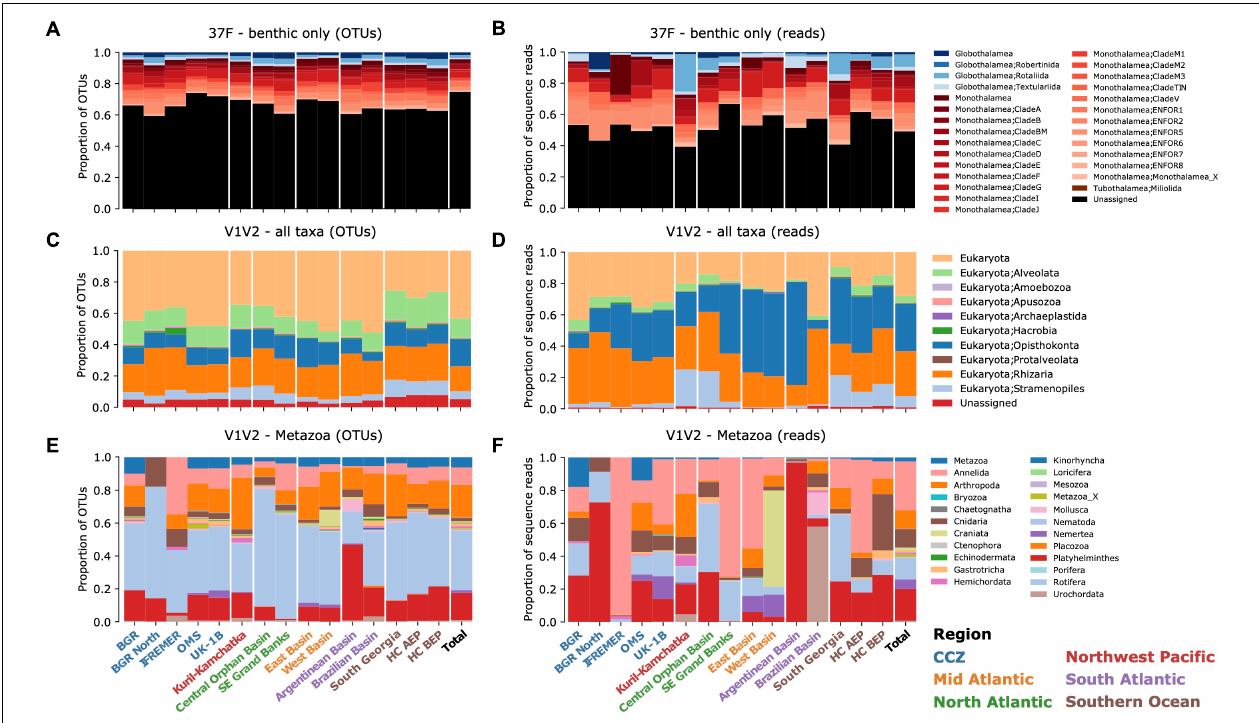
FIGURE 2 | Taxonomic composition and relative abundance. Proportions of OTUs found for each taxon across samples from each area (A,C,E) and relative abundances of reads per taxon (B,D,F) . (A,B) the 37F dataset (benthic Foraminifera only), (C,D) the full V1V2 dataset, and (E,F) the V1V2 dataset reduced to Metazoa. Bars are grouped per region and the total proportions are shown on the right of each